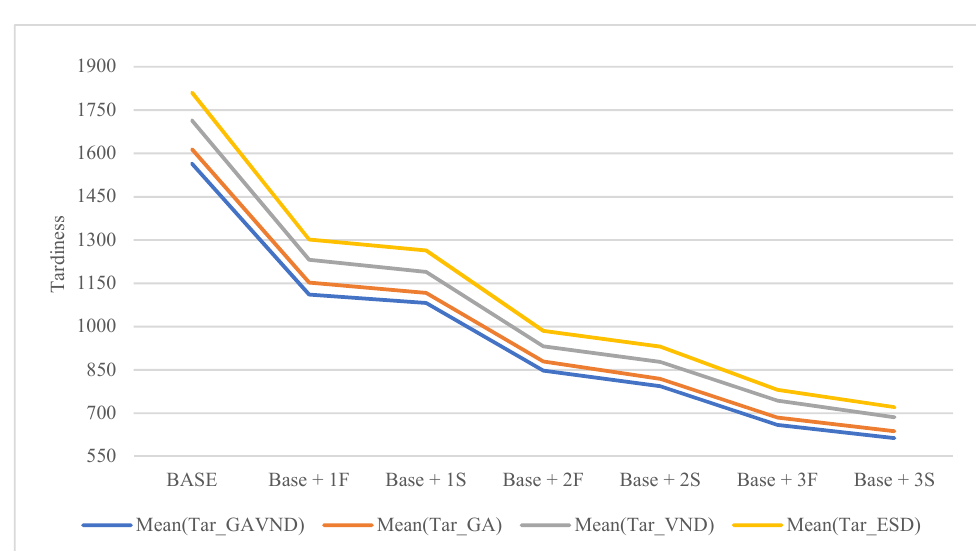
Figure 6. Effect of the heterogeneous workforce.